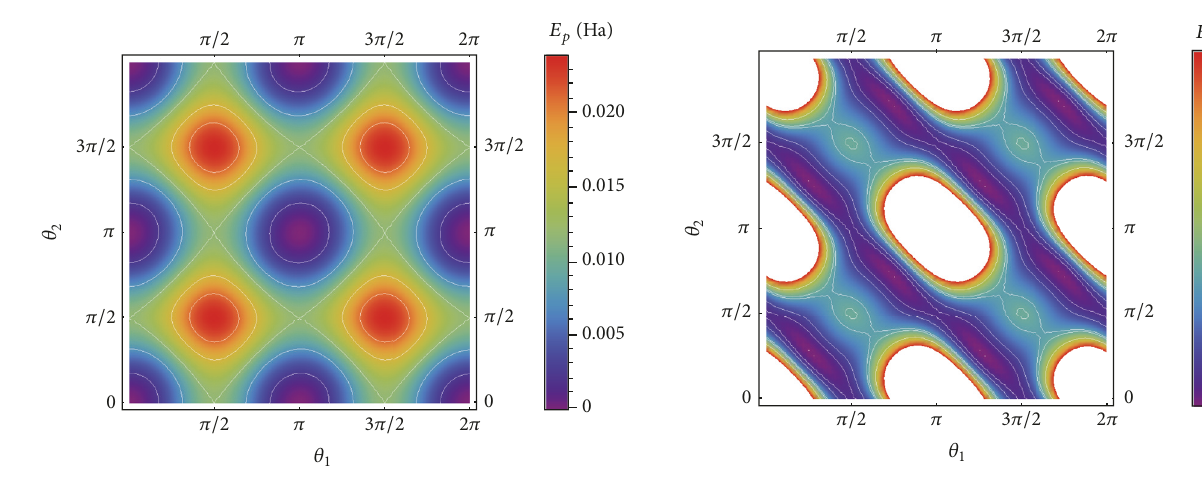
Figure 6: The torsional PES of metadinitrobenzene. The conforma- tionalenergies(inHartree)oftheminimaarezero,whilethebarriers around (0, 𝜋/2 ) are 0.0118 and 0.0239 at ( 𝜋/2, 𝜋/2 ).